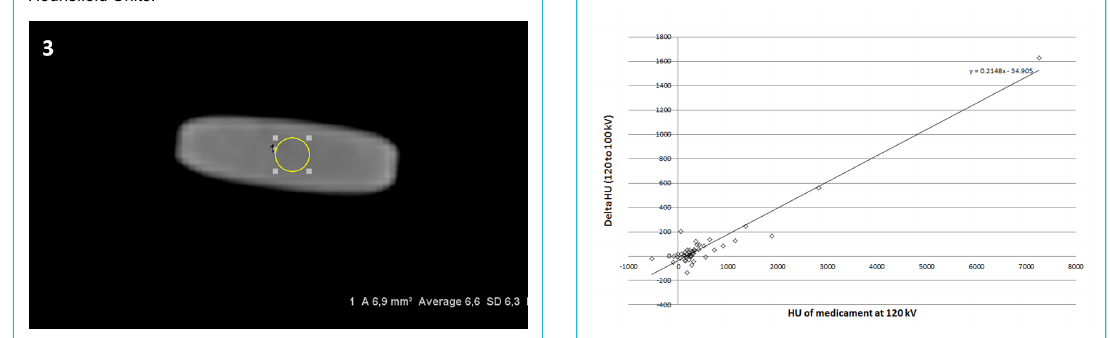
Figure 4: Spectroscopic increase of HU at lower tube